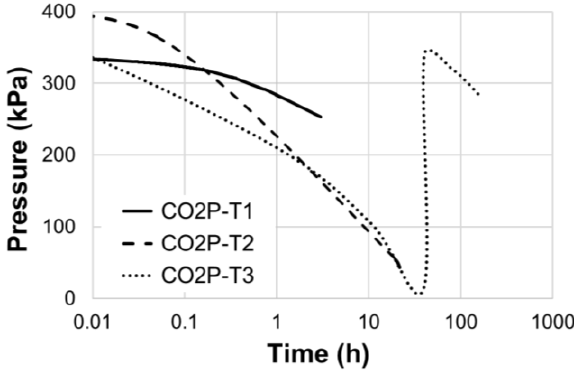
Figure 3. Pressure loss in the pressure vessel during CO 2 curing.